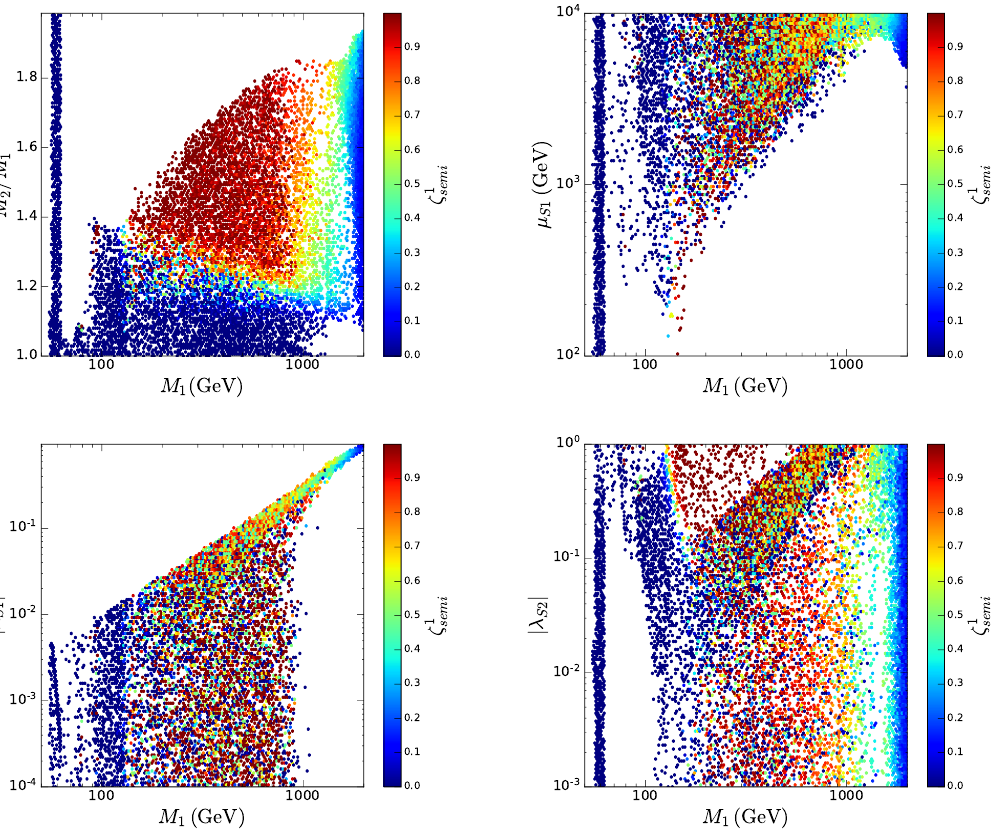
Figure 9 . Viable parameter space for (cid:22) S 2 = 0 and (cid:21) 3 i = (cid:21) 412 = 0. The free parame- ters ( M 2 =M 1 ; (cid:22) S 2 ; j (cid:21) Si j ) are displayed as a function of (cid:30) 1 mass and characterized by the semi- annihilation fraction (cid:16) 1 semi